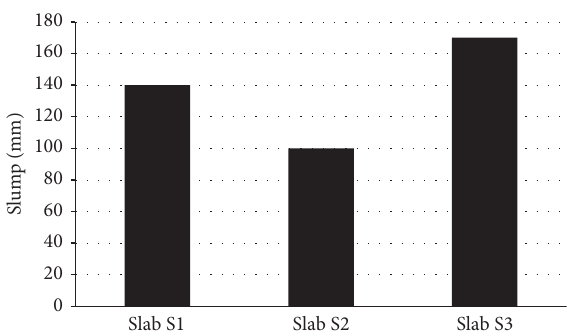
Figure 17: Stressing procedure.